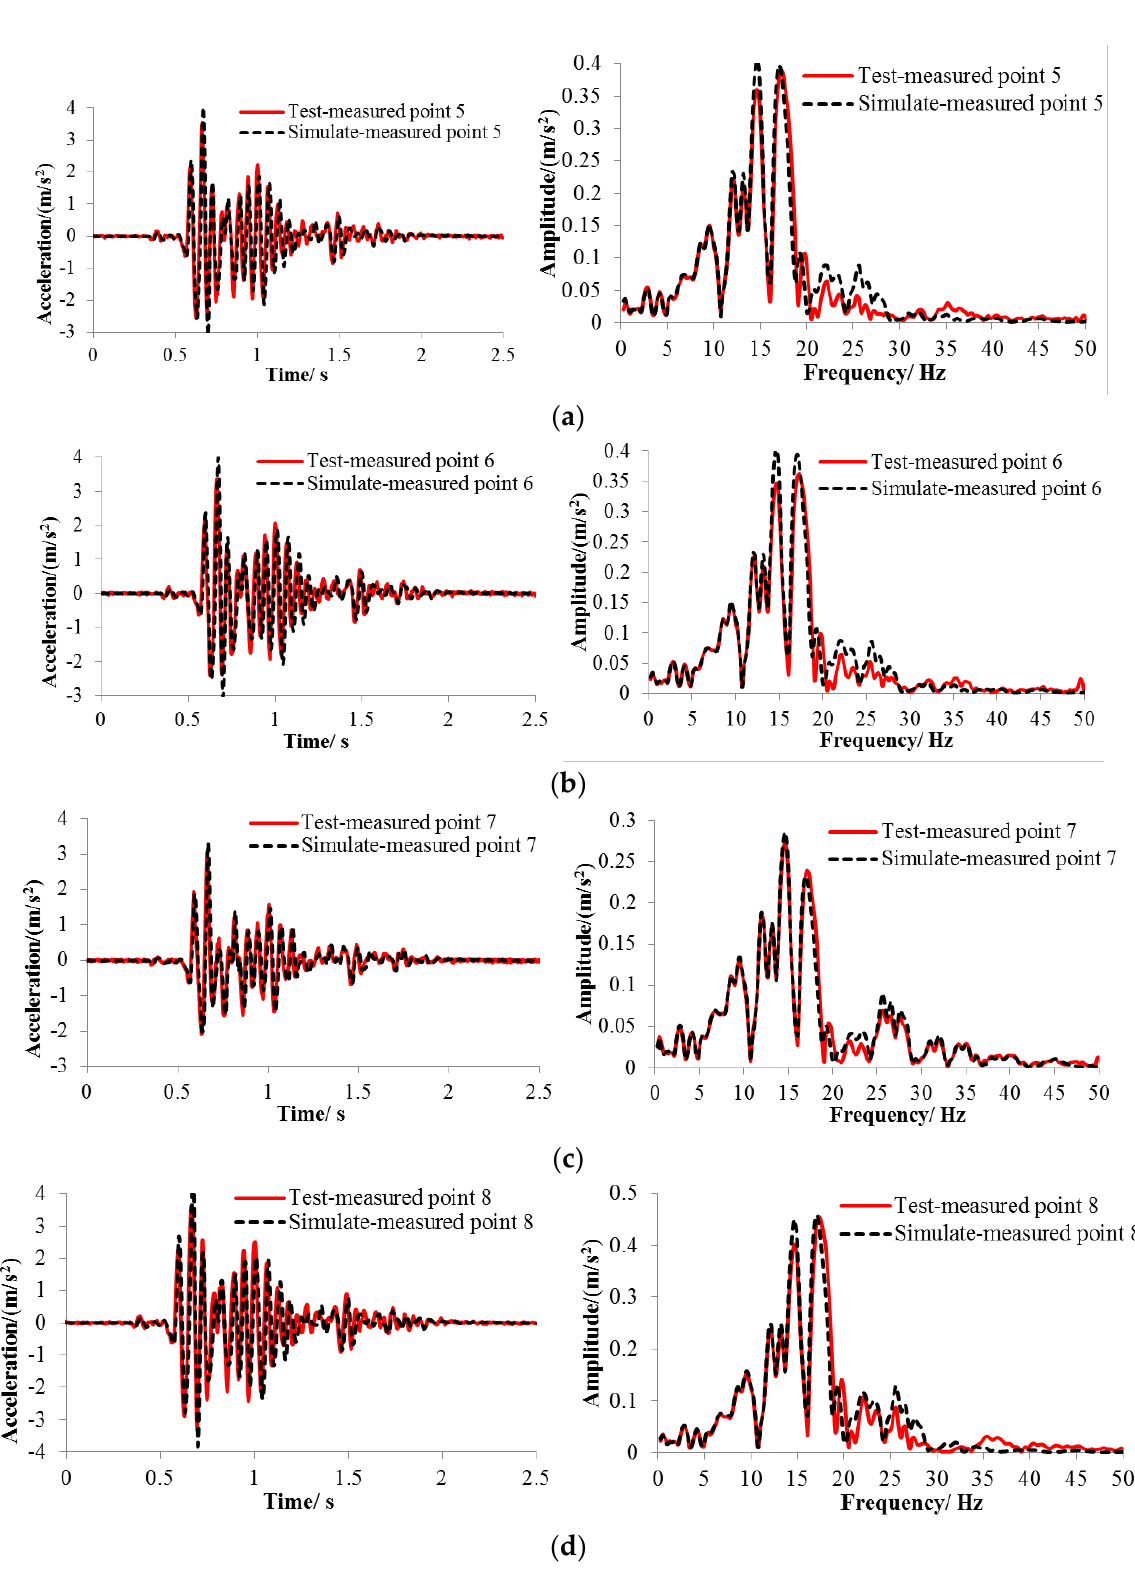
Figure 13. Responded accelerations of the test data and simulation results: ( a ) measured point 5; ( b ) measured point 6; ( c ) measured point 7; ( d ) measured point 8.